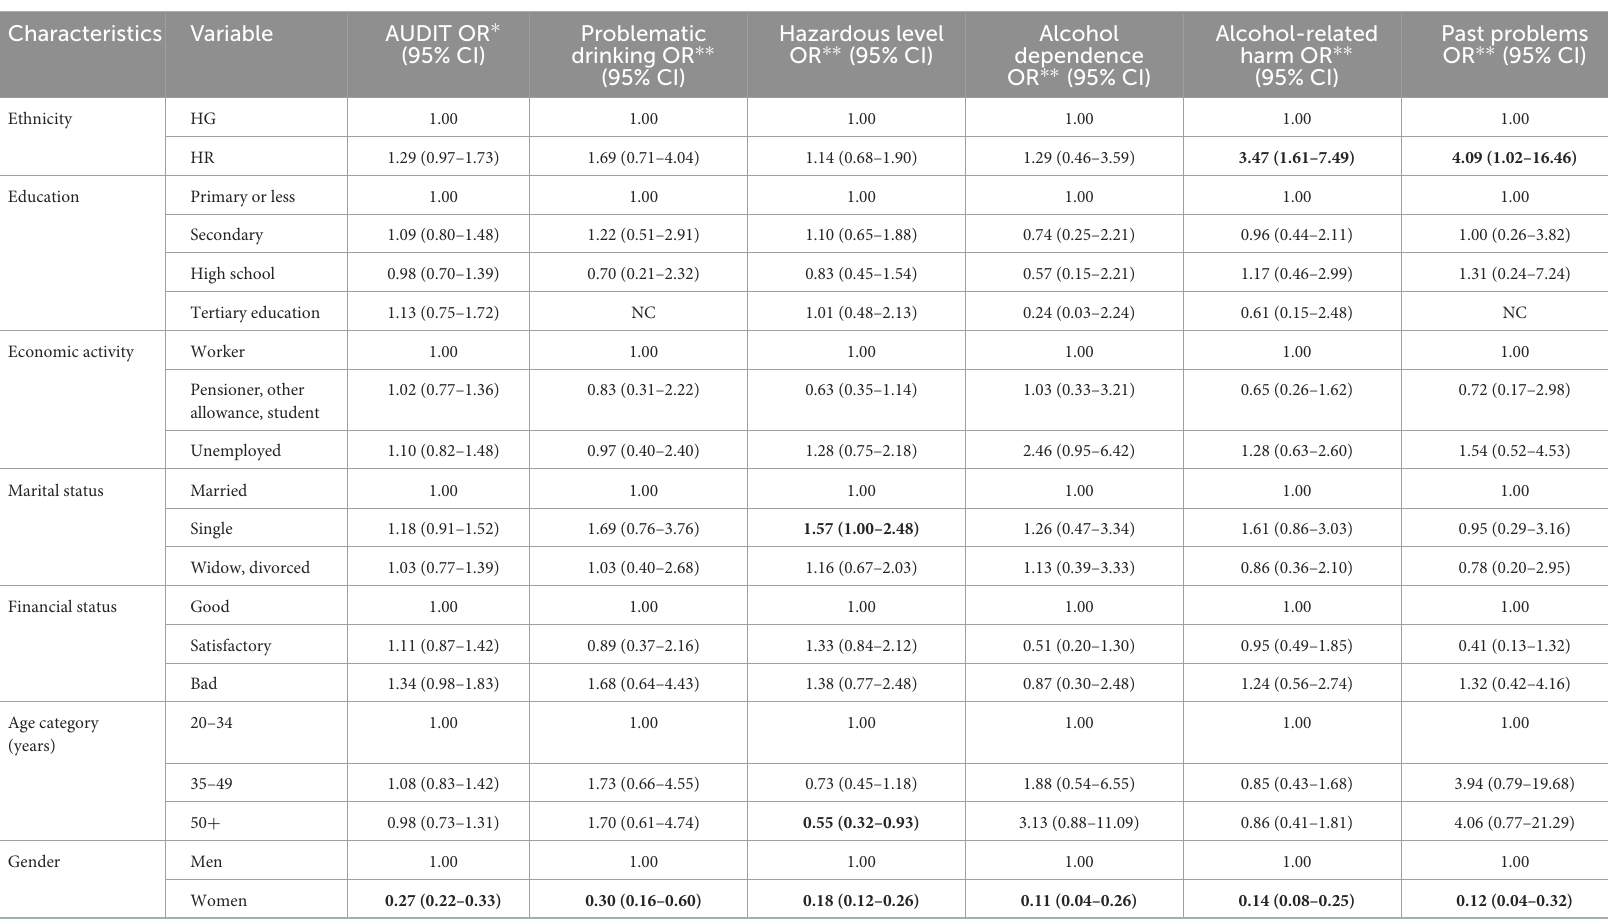
TABLE 5 Results of multivariate negative binomial and logistic regression analyses on alcohol use as measured by AUDIT questions, with socioeconomic factors and ethnicity as the primary independent variables under investigation.